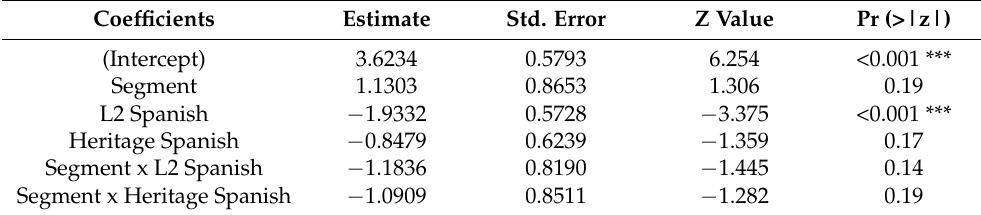
Table 4. Glmer model for segment and Spanish language status.